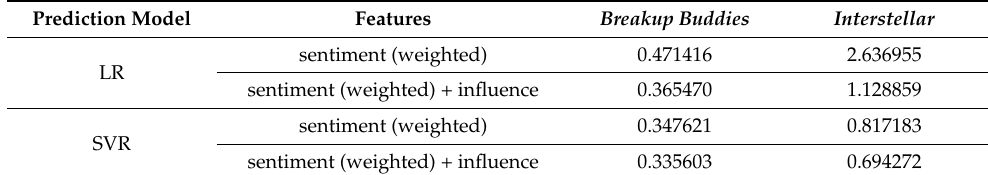
Table 6. MAPE with the influence